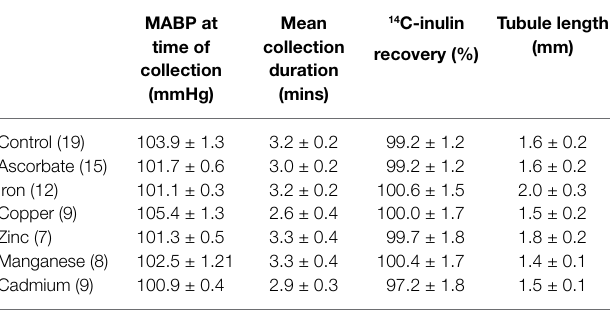
Values are means ± SEM; number of tubules in parentheses; 14 C-inulin recoveries were not significantly different from 100%. MABP at time of collection, collection duration, and tubule lengths were comparable in each group.